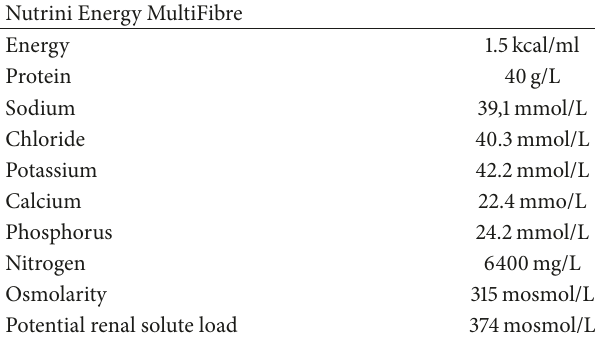
Table 2: Nutrini Energy